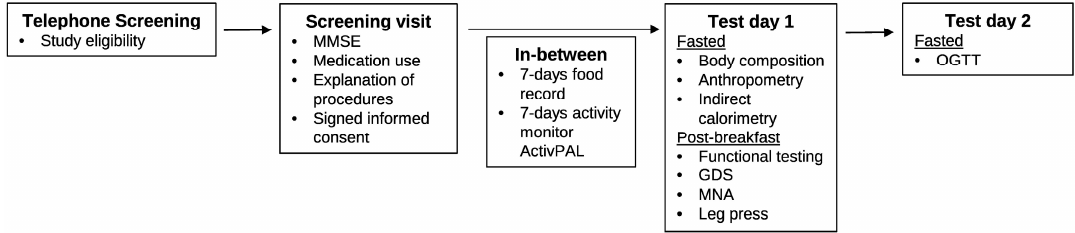
Figure 1. Study procedures. Abbreviations: MMSE: Mini Mental State Examination; GDS: Geriatric Depression Scale; MNA: Mini Nutritional Assessment; OGTT: oral glucose-tolerance test.